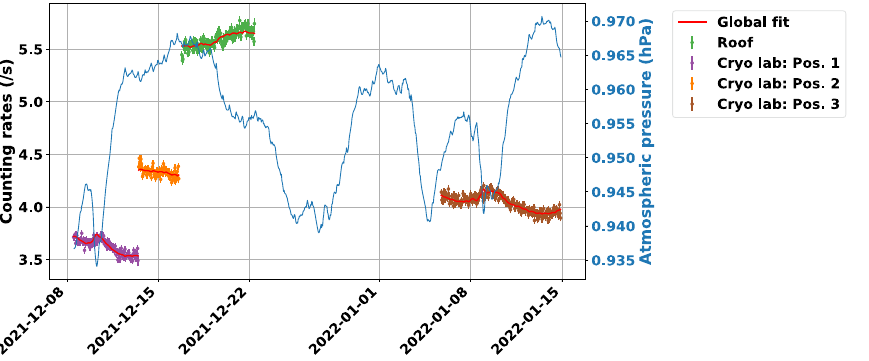
Fig. 6 Time evolution of the muon trigger rate at three different loca- tions in our IP2I cryogenic lab (purple, orange, and brown dots) and from the roof of the building to determine the muon trigger rate with no overburden (green dots). The blue curve shows the evolution in time of